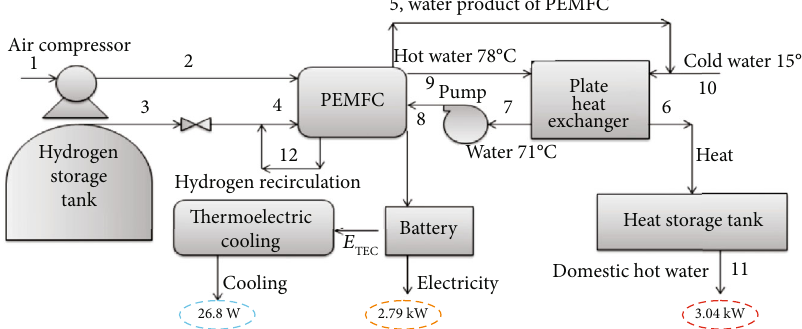
Figure 17: TEC and PEM fuel cell CCHP system (adapted from